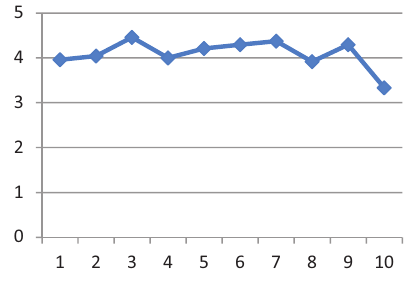
Table 5. Degree of residents’ involvement in planning the housing and doing “Gotong royong”